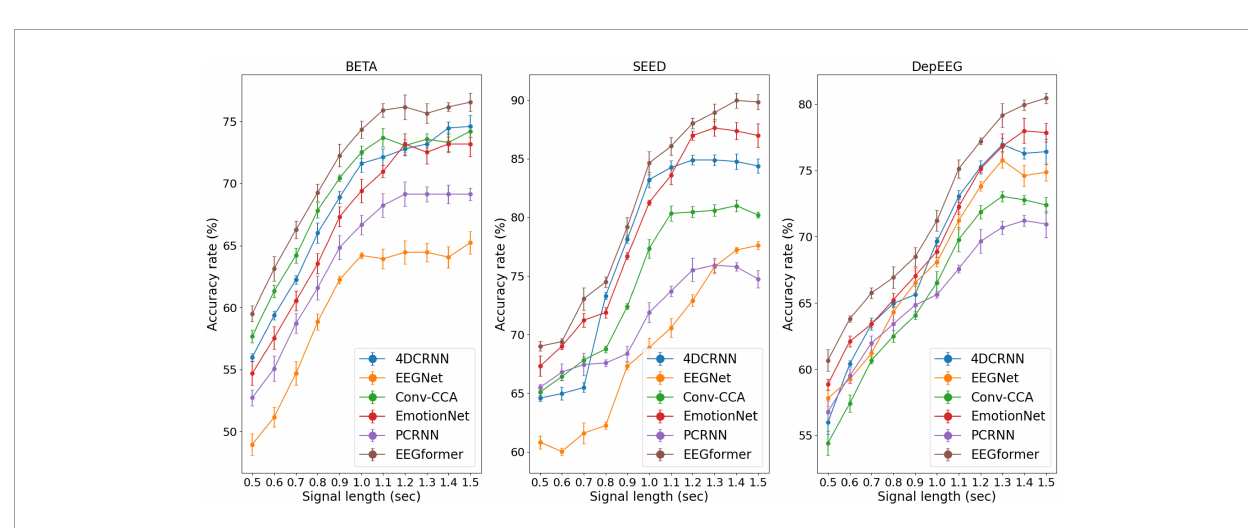
FIGURE5 Performance (average ACC ± SD %) of segment length T using the EEGformer and other comparable models on the three EEG datasets.